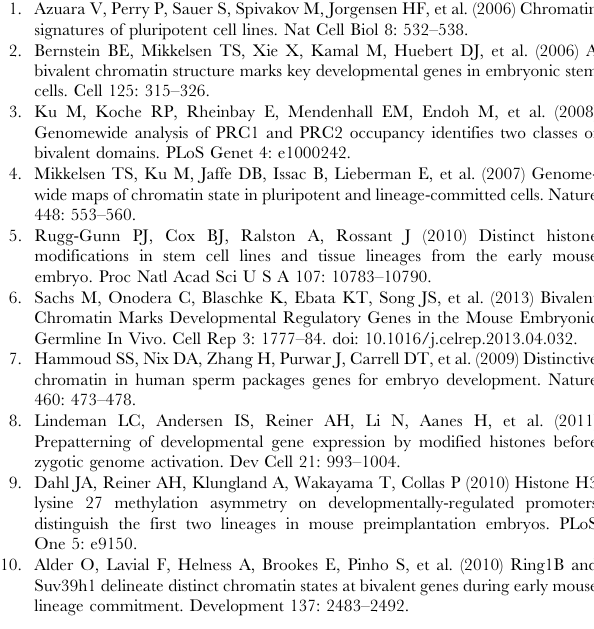
are highlighted in red. Also denoted is whether the promoter has a corresponding RA H3K4me3 MACS peak (listed as 1). (XLSX) Table S2 Promoters experiencing H3K4me3 reduction in KO RA differentiation. EdgeR statistical comparison for significant (FDR , 0.05) loss of H3K4me3 normalized sequence reads in KO RA relative to WT RA across the TSS + / 2 1 KB. Some genes have multiple alternative promoters, so genes that are duplicated within the list are highlighted in red. Also denoted is whether the promoter has a corresponding WT or KO ES H3K27me3 MACS peak (listed as 1). (XLSX) Table S3 KO RA H3K27me3 MACS peaks that have enrichment in H3K27me3 sequence reads over WT RA. EdgeR statistical comparison for significant (FDR , 0.05) increase in H3K27me3 normalized sequence reads in KO RA MACS peaks relative to WT RA across the KO RA peak center + / 2 0.5 KB. MACS peaks are listed with the nearest neighboring gene. Some genes are associated with multiple MACS peaks, so genes that are duplicated within the list are highlighted in red. Also denoted is whether the promoter of that gene has a corresponding reduction in KO RA H3K4me3 (listed as 1). (XLSX) Table S4 Primers used in the study.